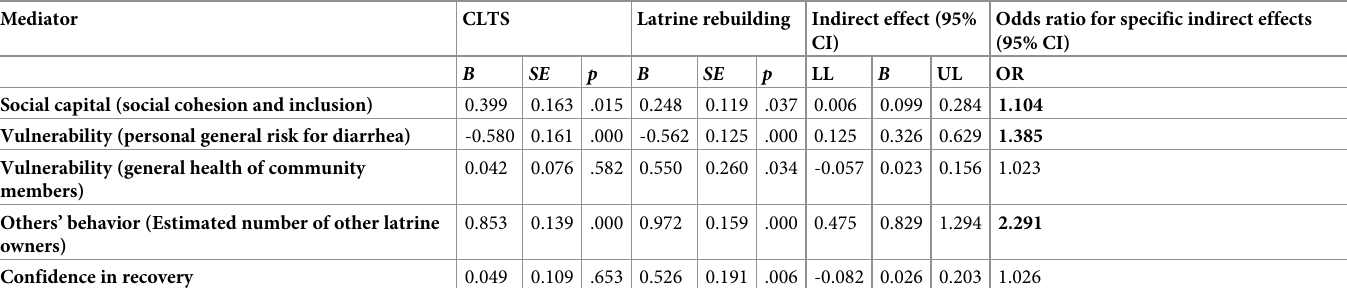
Table 4. Summary of multiple mediation analysis.